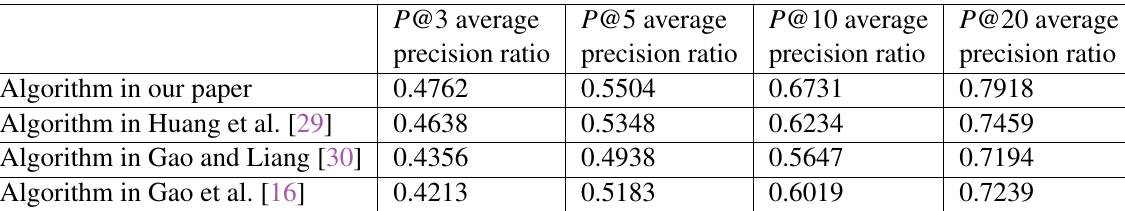
Table 1. The experiment results of ontology similarity